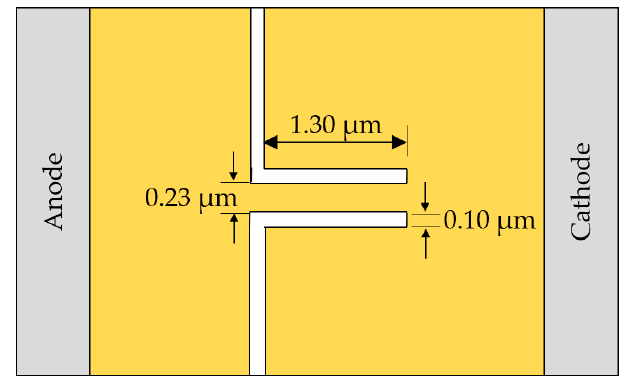
Figure 4. Optimized structure obtained from Taguchi method.